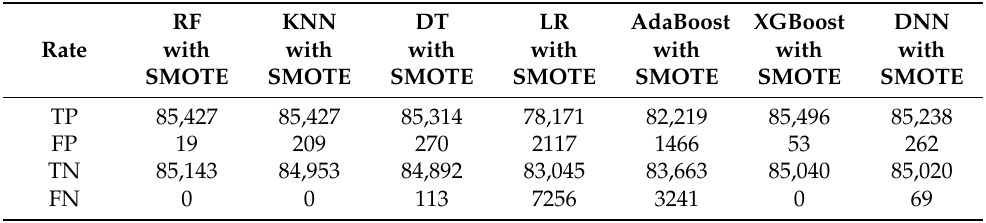
Table 7. TP, FP, TN, FN rates of machine learning algorithms with SMOTE based on resampling approach 1.